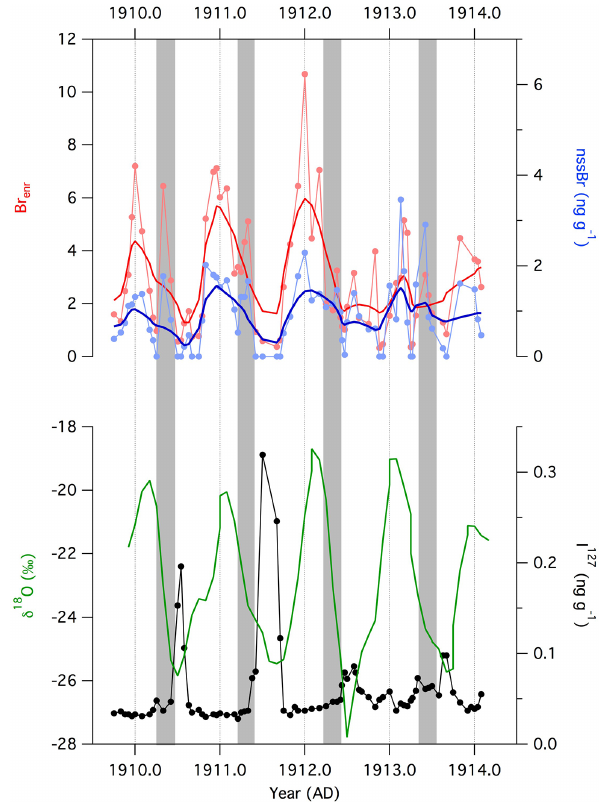
Figure 3. Seasonal variability in bromine and iodine is observed in the coastal East Antarctica Law Dome ice core. Bromine enrich- ment relative to seawater Br/Na mass values (Br enr , red) show the same trend as non-sea salt bromine concentrations (nssBr, blue). For both data sets, individual data (circles) and an 11-point binomial smoothing (thick lines) are shown. Iodine concentration seasonal- ity (black points) is clearly observed with respect to δ 18 O isotope ratios (green). Vertical grey bars highlight the presence of a late- autumn peak in nssBr and Br enr